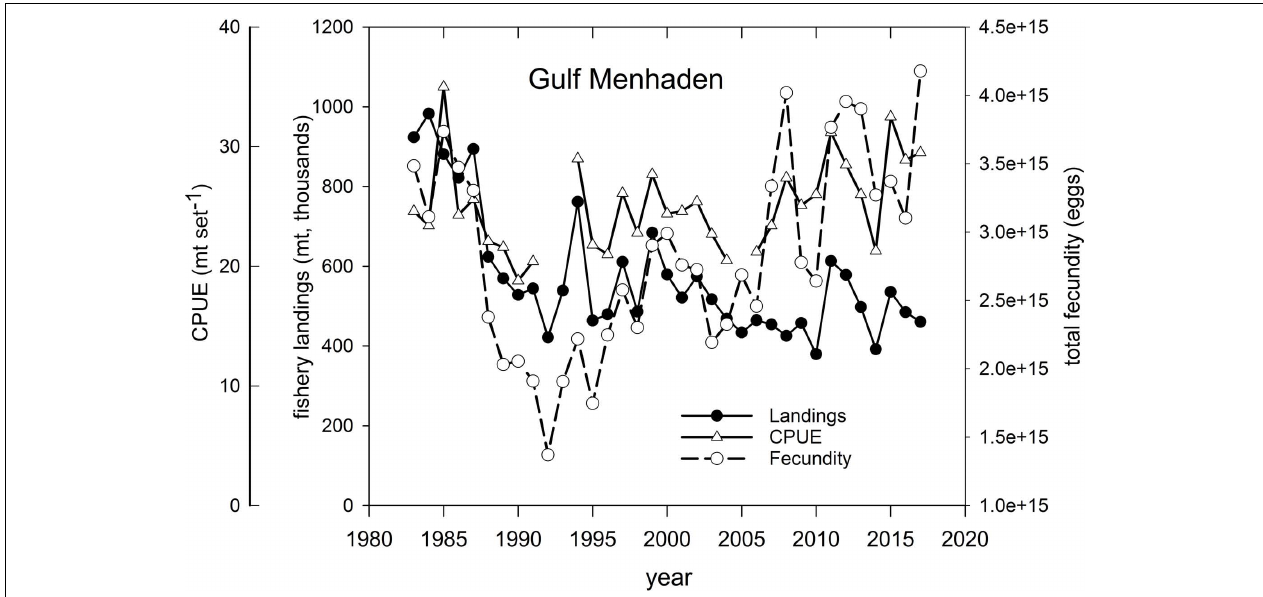
FIGURE 12 | Annual fishery landings (thousands of metric tons), relative abundance [measured as mean standardized catch (mt) per purse seine set) and estimated total population fecundity of Gulf Menhaden, 1983–2017. Graph was developed from information provided in SEDAR